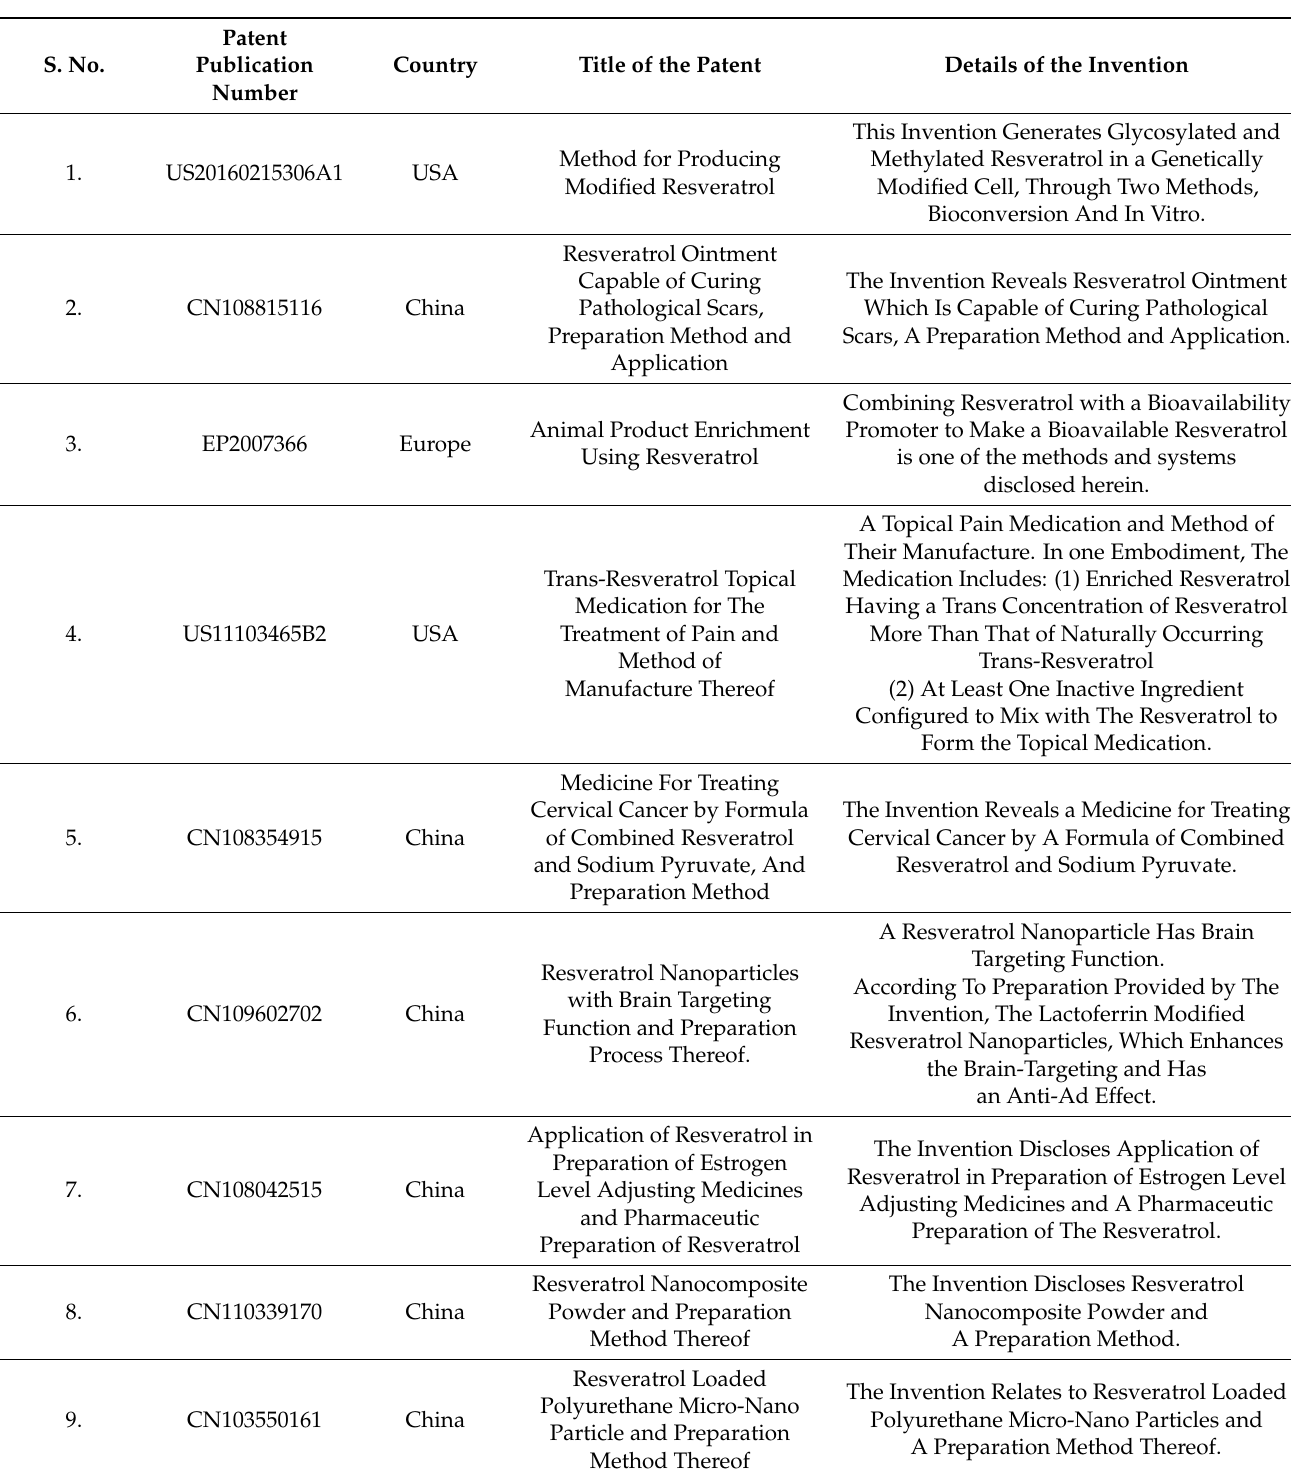
Table 6. List of Patent on Resveratrol